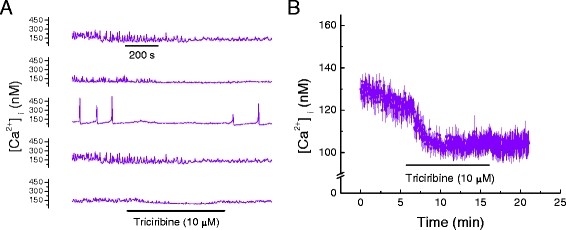
Akt-PKB inhibition with triciribine decreases Ca
2+
, [Ca
2+
]
i
, in HL-1 cell mouse cardiomyocytes.
A
. Effect of triciribine (10 μM) on [Ca2+]i oscillations in five representative HL-1 cells. Time base applies to all traces.
B
. Effect of triciribine (10 μM) on average [Ca2+]i in cells displaying oscillating and non-oscillating [Ca2+]i (mean ± SEM; n = 5, each an average of 25 to 40 cells as shown in A).